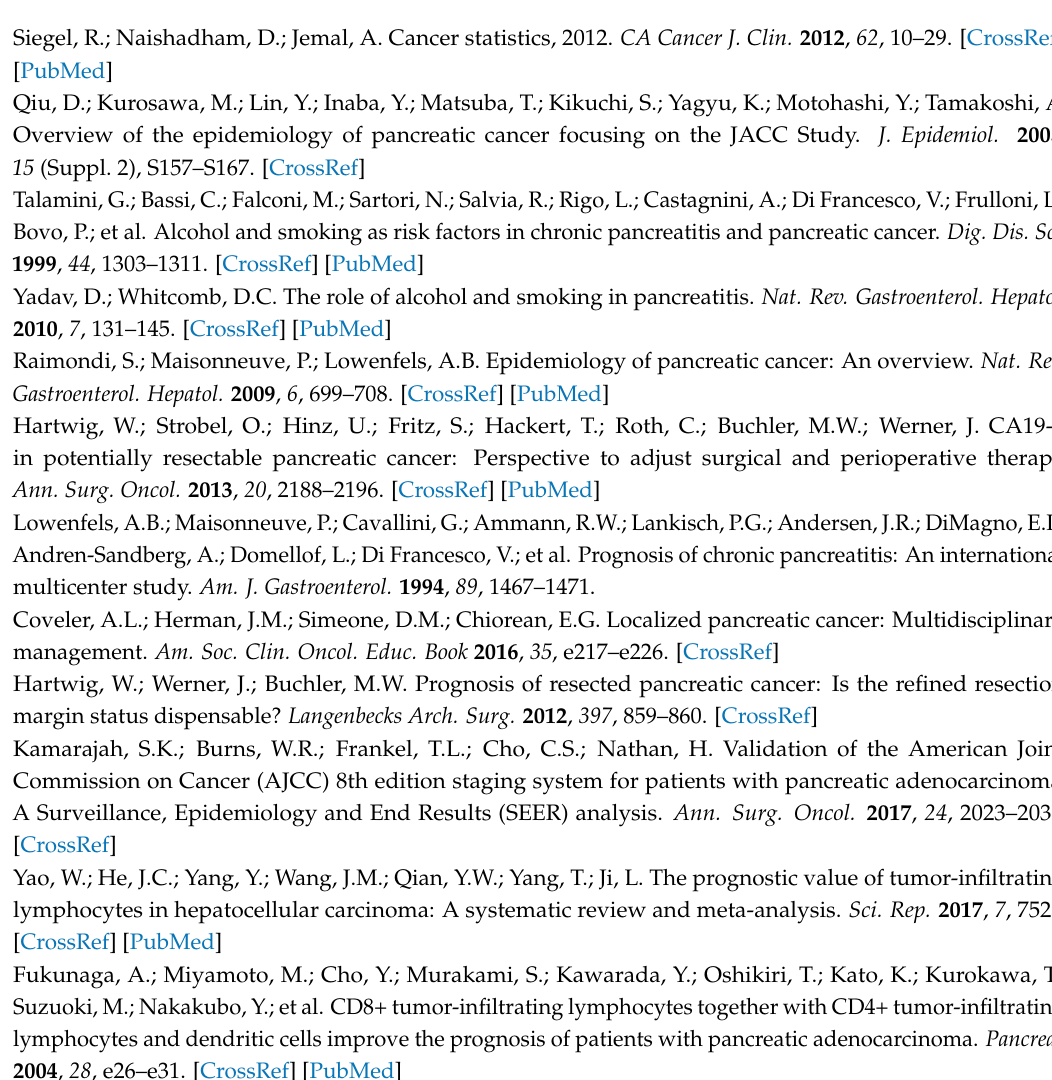
Figure S1: Extensive necrosis (grade 0–2) was correlated with impaired overall (A) and progression-free survival (B). Figure S2: (A–C) Kaplan-Meier curves for overall survival (OS) and quality of the tumor stroma and for progression-free survival (PFS) and quality of the tumor stroma (D–F). Figure S3: Receiver operating characteristic (ROC) curves for CD3 + , CD8 + , CD20 + , and CD66b + cells and combinations in relation to OS after 24 months. Figure S4: (A) On the left, a CD8+ TIL hot spot under a power field of 40 × magnification with the microscope and on the right, the tumor front. (B) The distance between the hot spot and the tumor front was calculated using the ZEN 2 lite software (ZEN 2.0, Carl Zeiss, Jena, Germany), choosing 3 differences in this 2D-model and determining the mean value of the